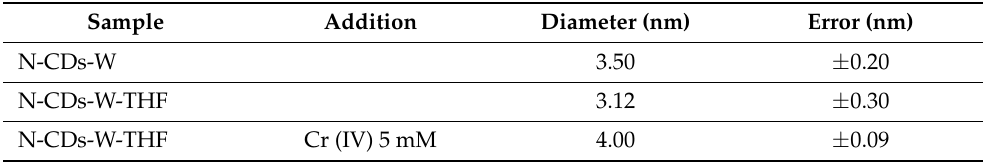
Table 1. Average hydrodynamic diameter 2RH from DLS measurements determined by intensity- weighted size distribution NNLS